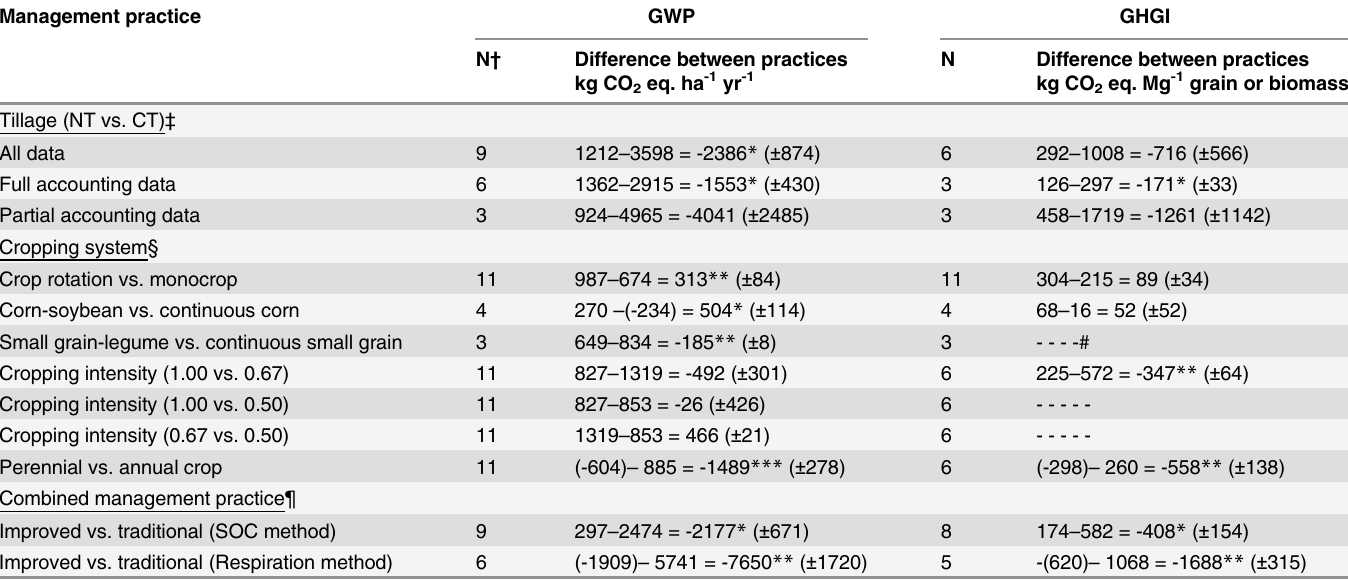
Table 6. Effect of various management practices on net global warming potential (GWP) and greenhouse gas intensity (GHGI) based on the meta- analysis. Values for difference between practices are denoted as mean ( ± standard